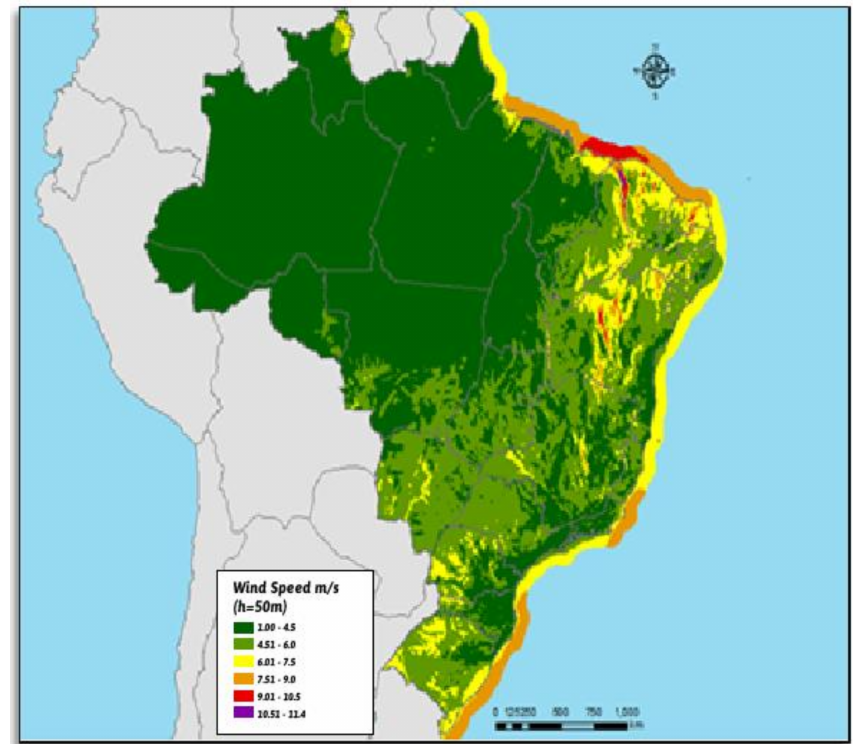
Figure 5. Wind Energy Potential—Brazil (50 m). Source: Elaborated by the author based on CRE- SESB (2018)